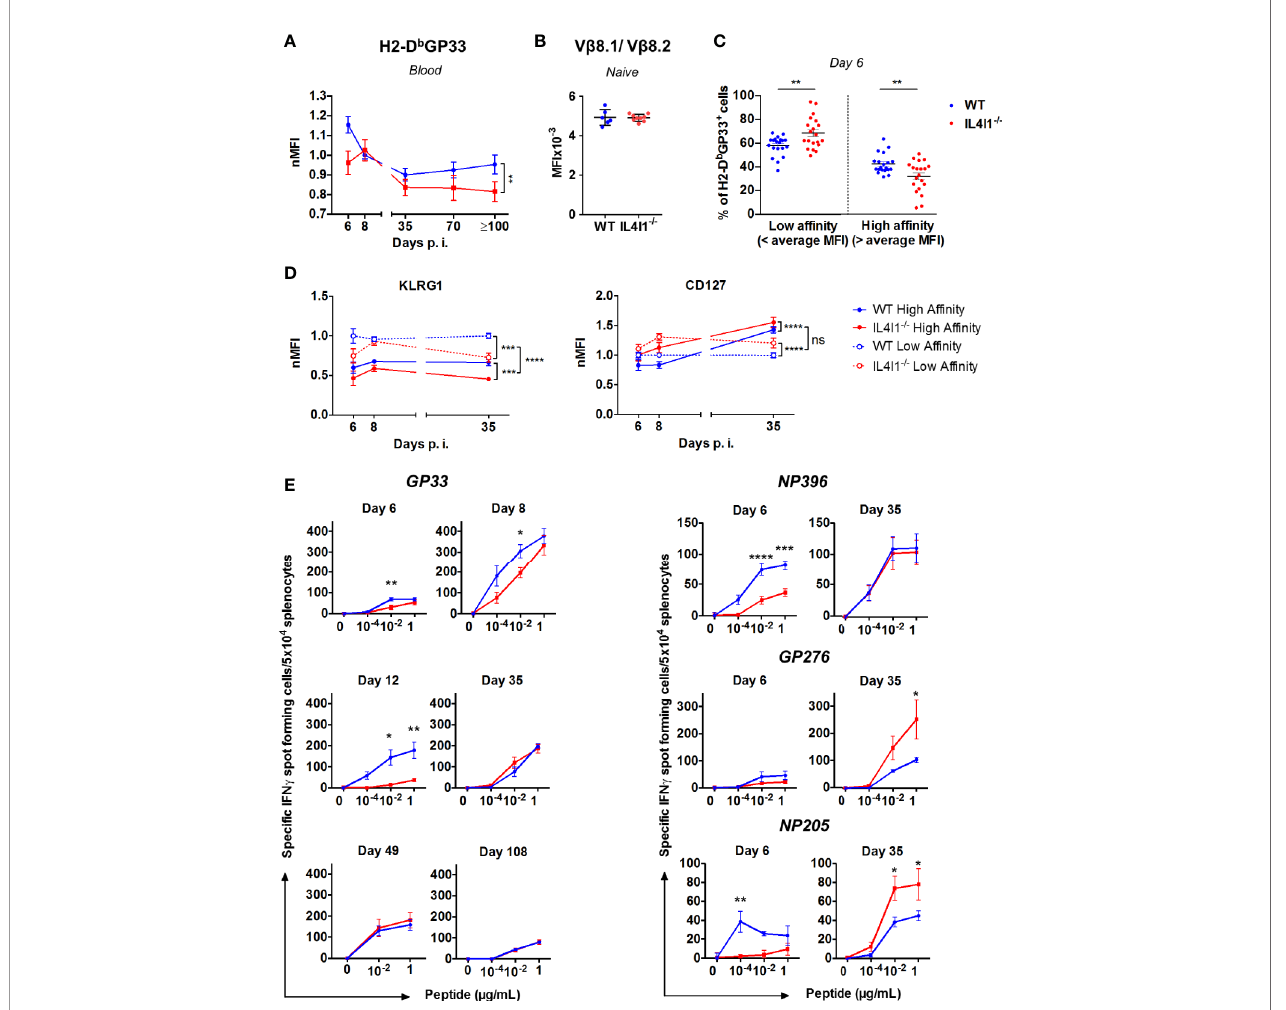
FIGURE 7 | IL4I1-induced differences in the af fi nity and avidity of the LCMV-speci fi c CD8 + T cell repertoire. WT (blue) and IL4I1 -/- (red) mice were infected i.v. with LCMV on day 0 (A) . TCR af fi nity estimated by tetramer binding. The MFI of H2-D b GP33 on H2-D b GP33 + CD8 + T lymphocytes was determined in blood samples from day 6 to ≥ day 100 p.i. and normalized against the average MFI obtained at day 8 in the WT mouse group for each experiment. Results were obtained from at least three independent experiments (day 6, n= 6; day 8, n=13; day 35, n=7, day 70, n=3, day 100, n=3) with three to four mice per group. ** p < 0.005 (two-way ANOVA) (B) . Comparison of TCR V b 8.1/V b 8.2 levels (MFI) in uninfected WT and IL4I1 -/- mice (C) . Circulating high-af fi nity and low-af fi nity H2-D b GP33 + CD8 + T cell subsets on day 6 were segregated by the respective average H2-D b GP33 MFI in WT and IL4I1 -/- mice. ** p < 0.005 (Student t test) (D) . High-af fi nity (plain line) and low-af fi nity (dotted line) GP33-speci fi c cells, as determined in panel C, were analyzed for their KLRG1 and CD127 levels (MFI were normalized at each time point to the WT low-af fi nity results) at days 6, 8, and 35 p.i. Results from 6 to 12 independent experiments ( ≥ 20 mice per time point). NS: not signi fi cant, *** p < 0.001, **** p < 0.0001 (two-way ANOVA) (E) . Evolution of the functional avidity of CD8 + T cells responding to the immunodominant peptides GP33 (left) and NP396, GP276, and NP205 (right) assessed by ELISPOT-IFN g with graded peptide dilutions. Results from one to four independent experiments with 3 (day 12) to 12 (day 8) mice tested per group. * p < 0.05, ** p < 0.005, **** p < 0.0001 (two-way ANOVA with Sidak ’ s multiple comparison). All data are expressed as the mean ±